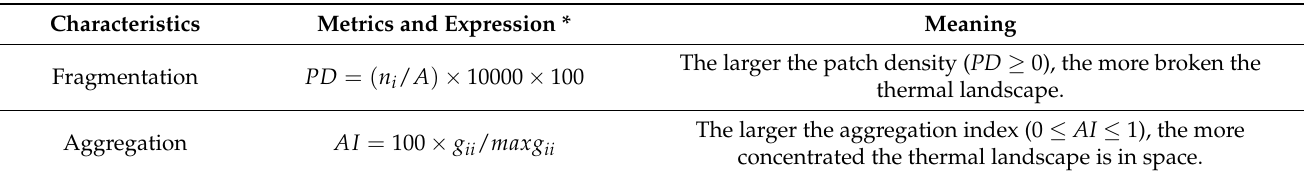
Table 3. The formula and significance of landscape